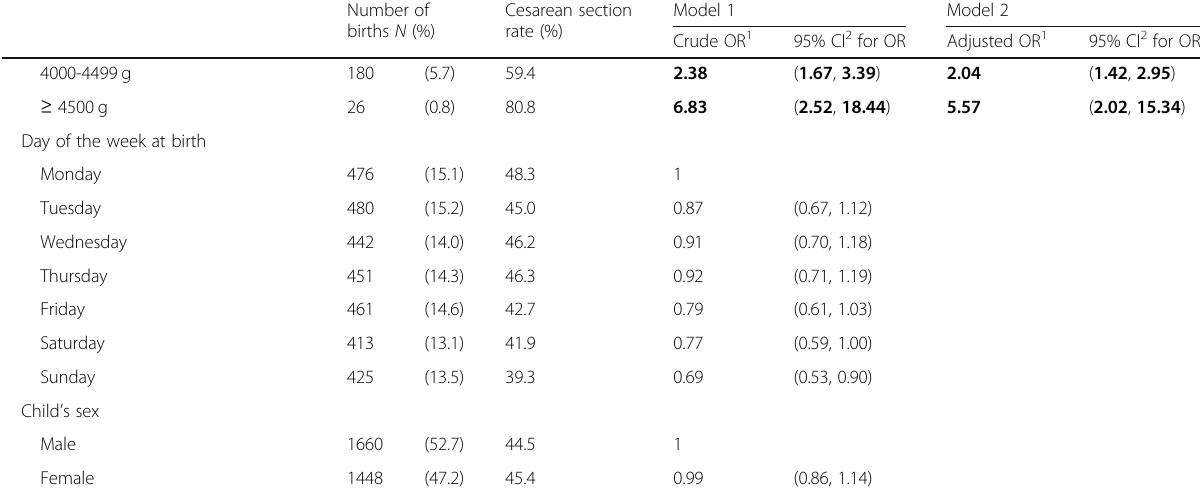
Table 2 shows number of birth (percentage) and cesarean section rate in socio-demographic, obstetric, and institutional variables. Model 1 displays the results of crude odds ratio (Crude OR) and confidential interval (CI) of the socio-demographic, obstetric, and institutional variables for cesarean section rate. Model 2 displays the results of adjusted OR (AOR) and CI of significant variables in model 1 for cesarean section rate 1 OR odds ratio, bold number, statistical